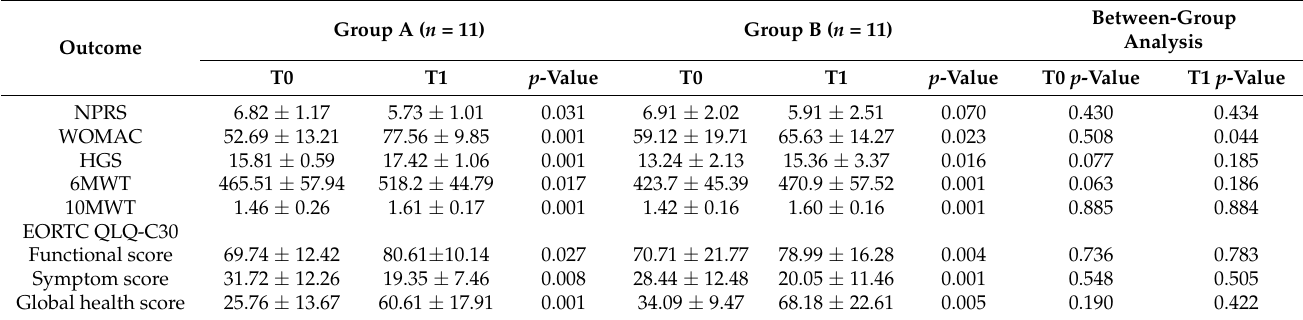
Table 2. Intra-group and between-group differences in outcome measures in the two